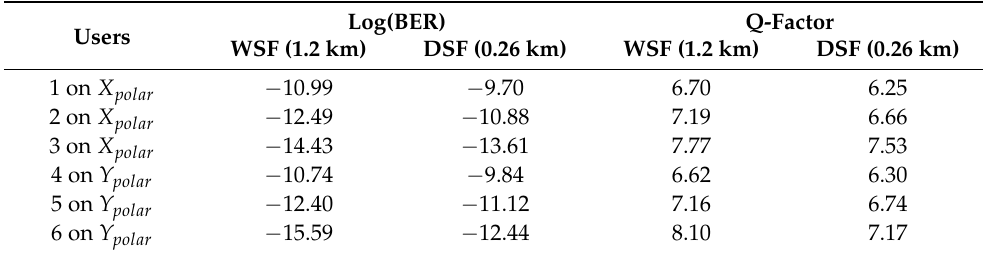
Table 7. Performance results for snow weather